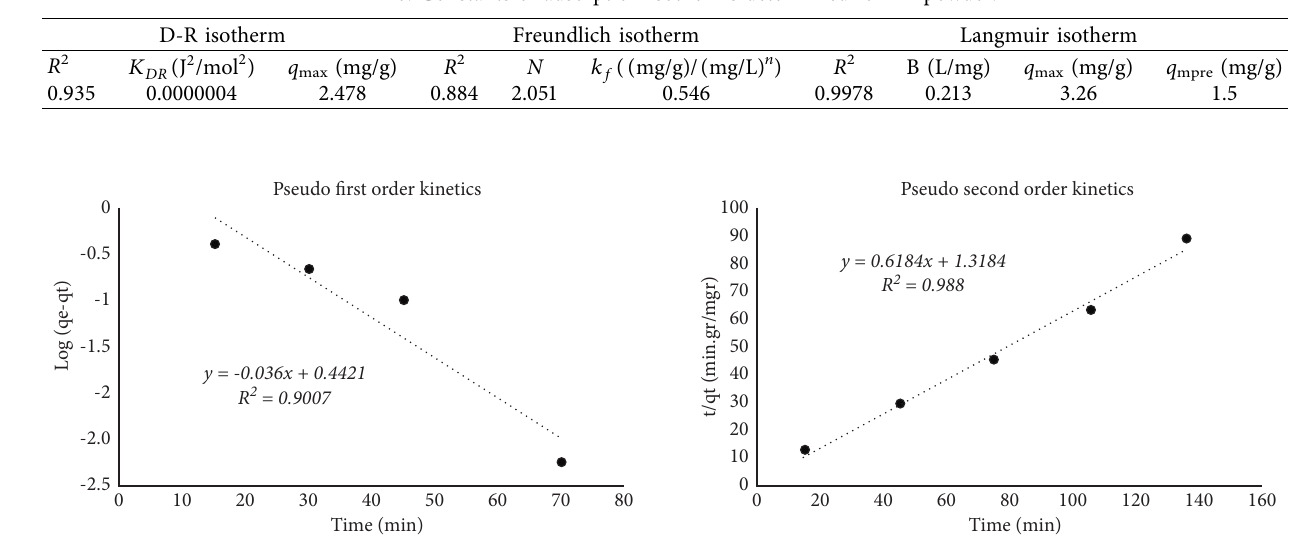
Table 6: Constants of adsorption isotherms determined for TT powder.